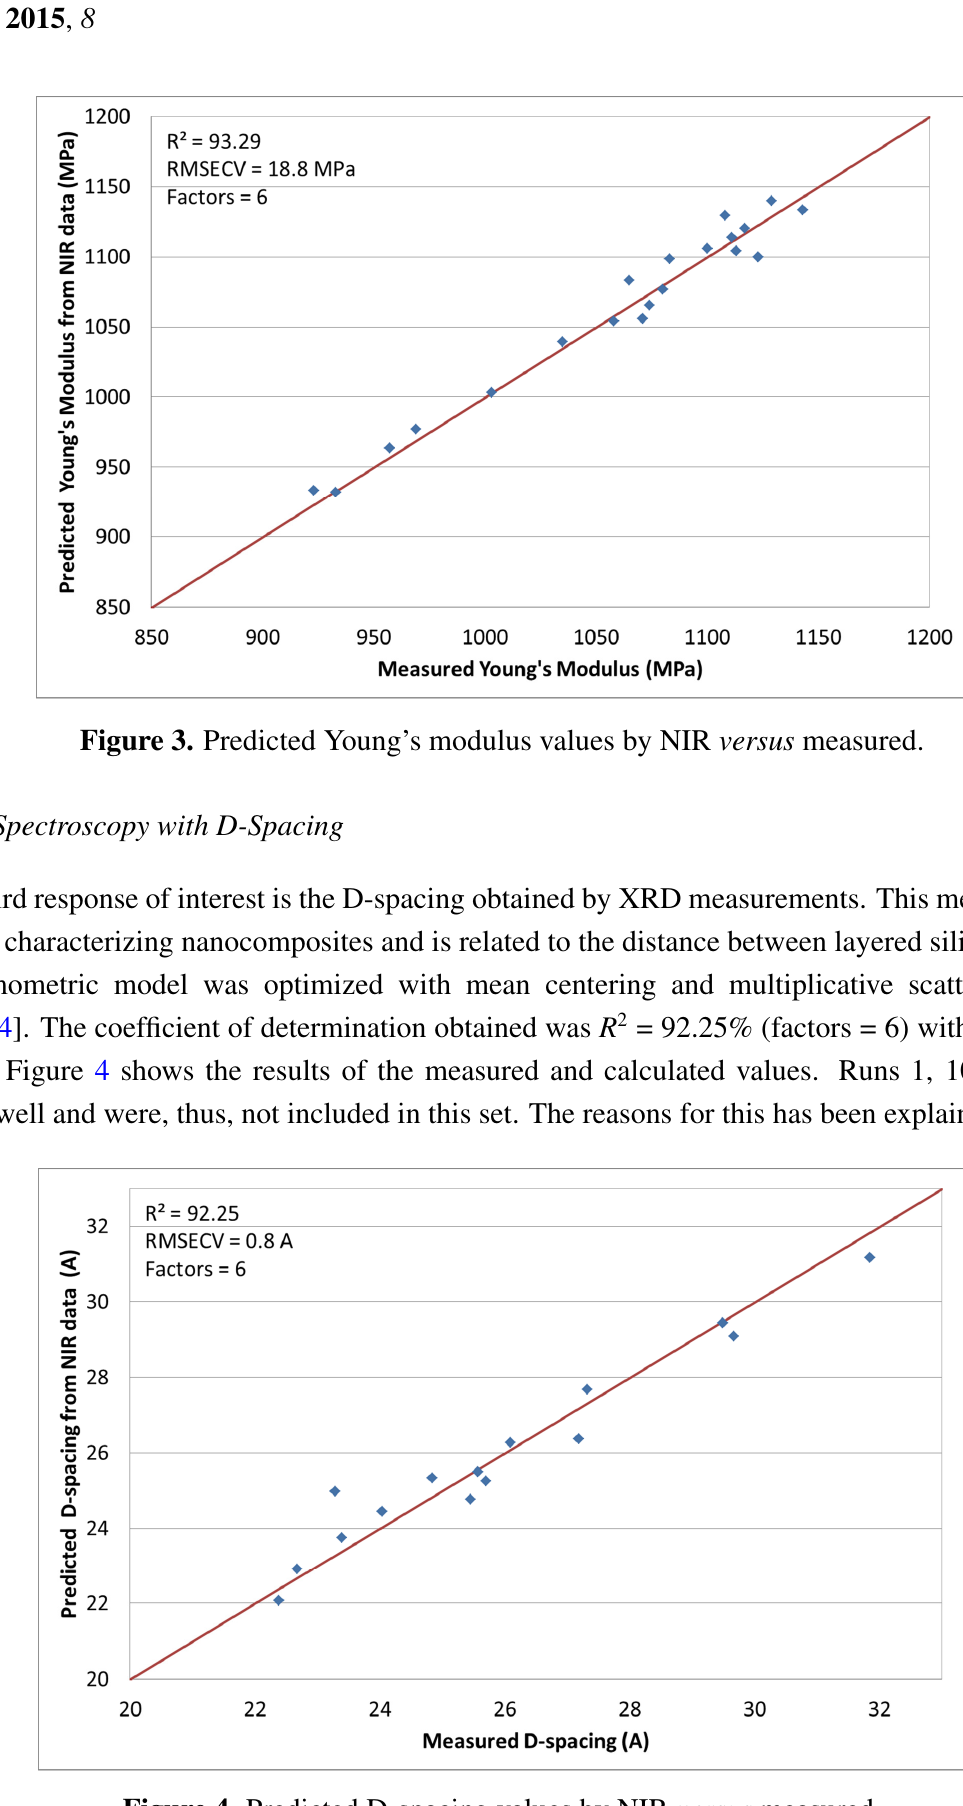
Figure 4. Predicted D-spacing values by NIR versus measured.